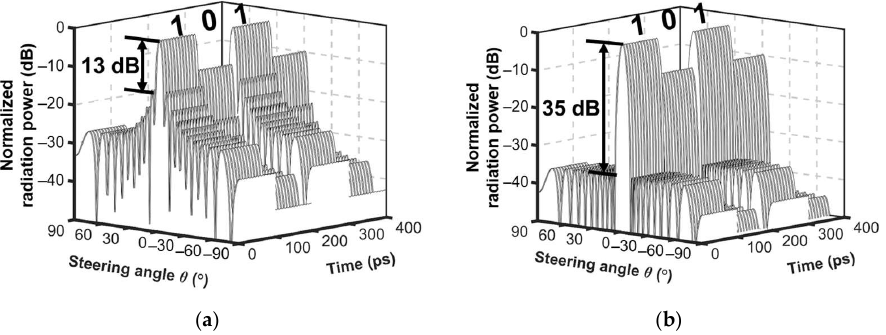
Figure 6. Modulated far-field radiation pattern of OIL-OPA Tx for OWC. ( a ) OPA Tx with uniform amplitude distribution; ( b ) OPA Tx with Taylor window function.